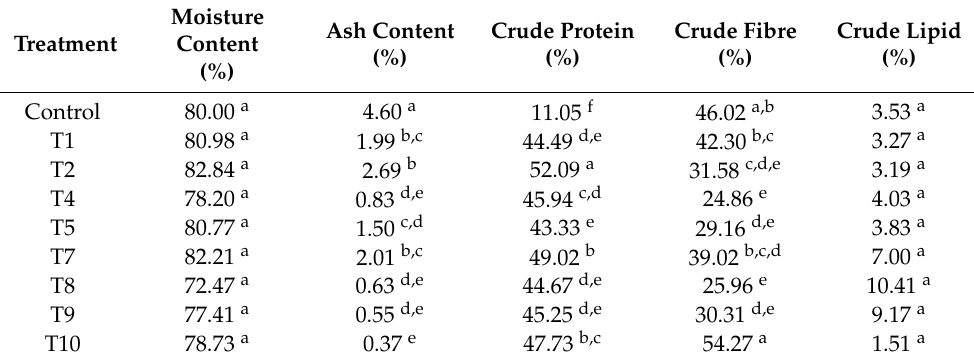
Table 7. Proximate composition of Pleurotus ostreatus